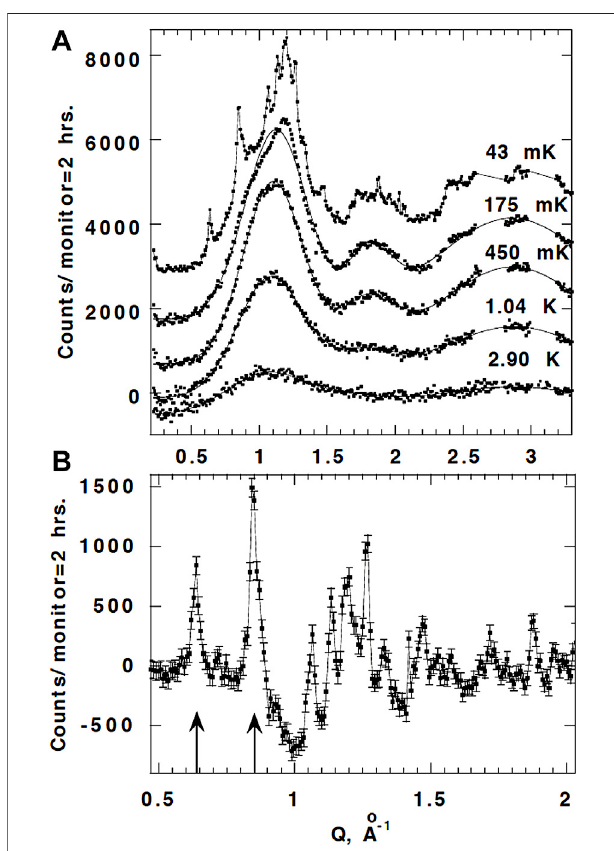
FIGURE 6 | (A) Low-temperature neutron diffraction data for GGG after subtracting the 9 K data. The curves for different temperatures are separated by 1,200 counts for clarity. (B) Difference plot for temperatures 0.043 and 0.175 K underlining the appearance of the sharp magnetic peaks at the lowest temperatures